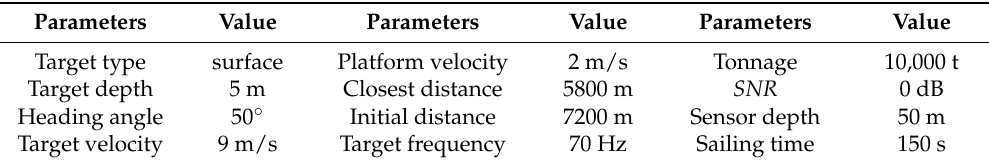
Table 4. Target simulation parameters of the surface target.